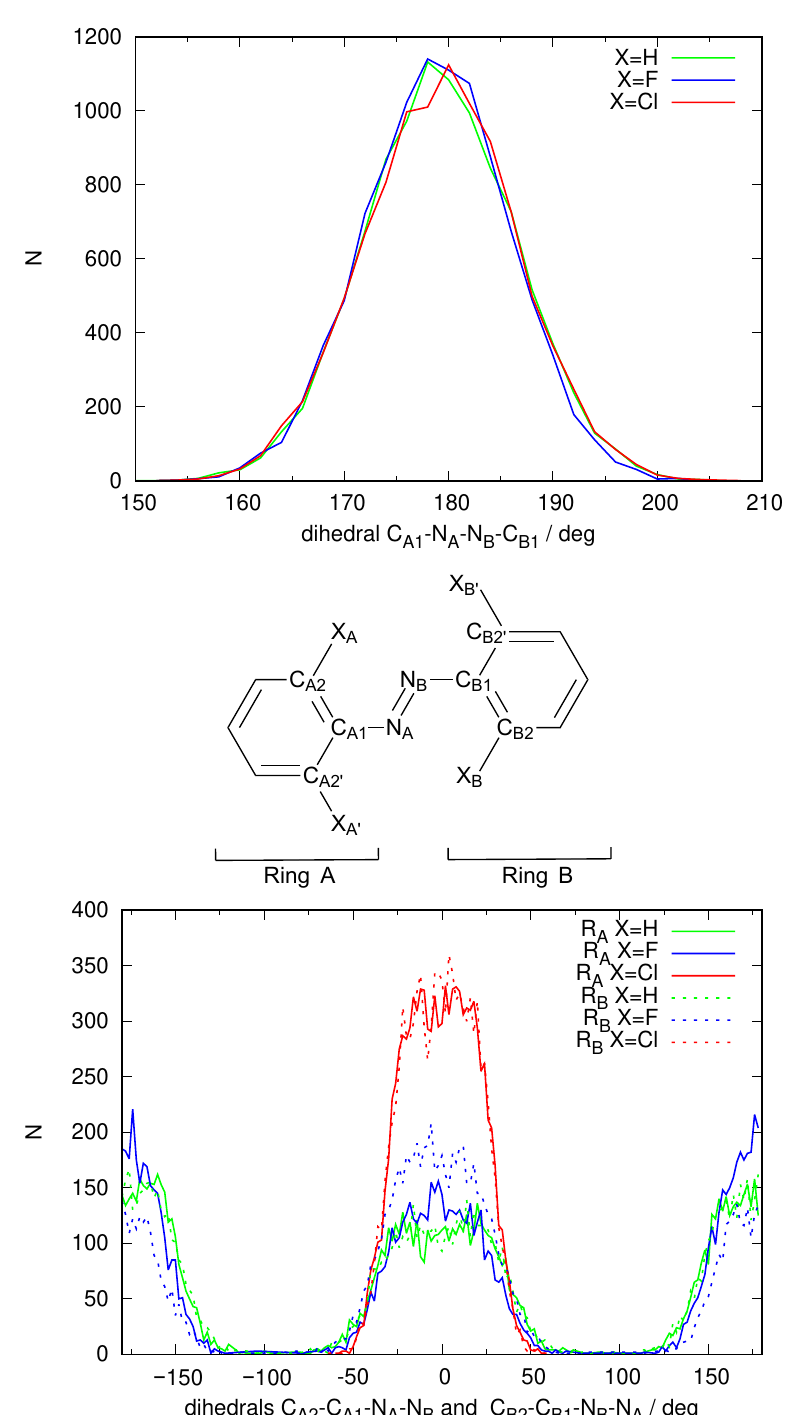
Figure 5. Distribution of the values of specific geometric parameters over the QM/MM MD simu- lations using a DFTB description of the solute molecules used to construct the spectra for the three different azobenzene derivatives with X=H (azobenzene), F and Cl as shown in Figure 6. Labels of the atoms are defined on the structure in the center. Top: distribution of the dihedral defining the E - Z configuration of the N=N double bond; Bottom: distribution of the dihedral defining the inclination of the two phenyl rings with respect to the azo